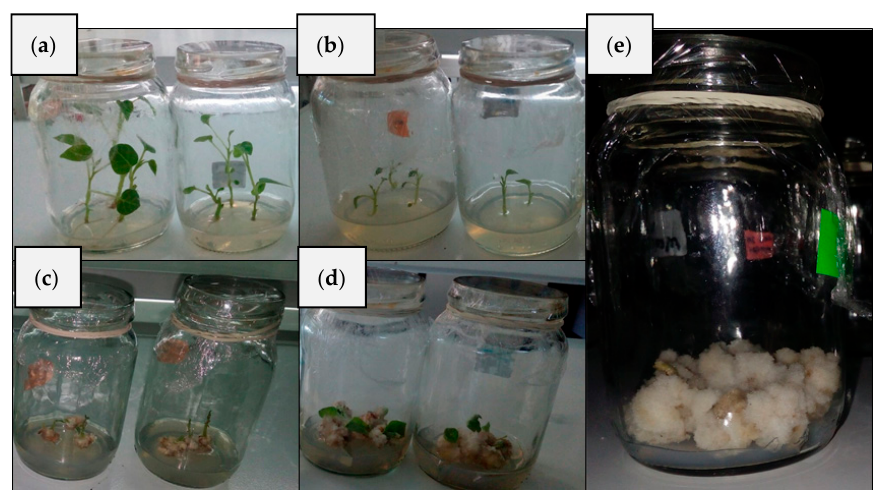
Figure 1. Solanum betaceum : ( a ) germinated plants, (b ) callus planting, ( c ) two-week-old callus, ( d ) four-week-old callus, ( e ) four-week-old tobacco callus. Table 1. (*). Percentage of embryogenic callus formation of Solanum betaceum .